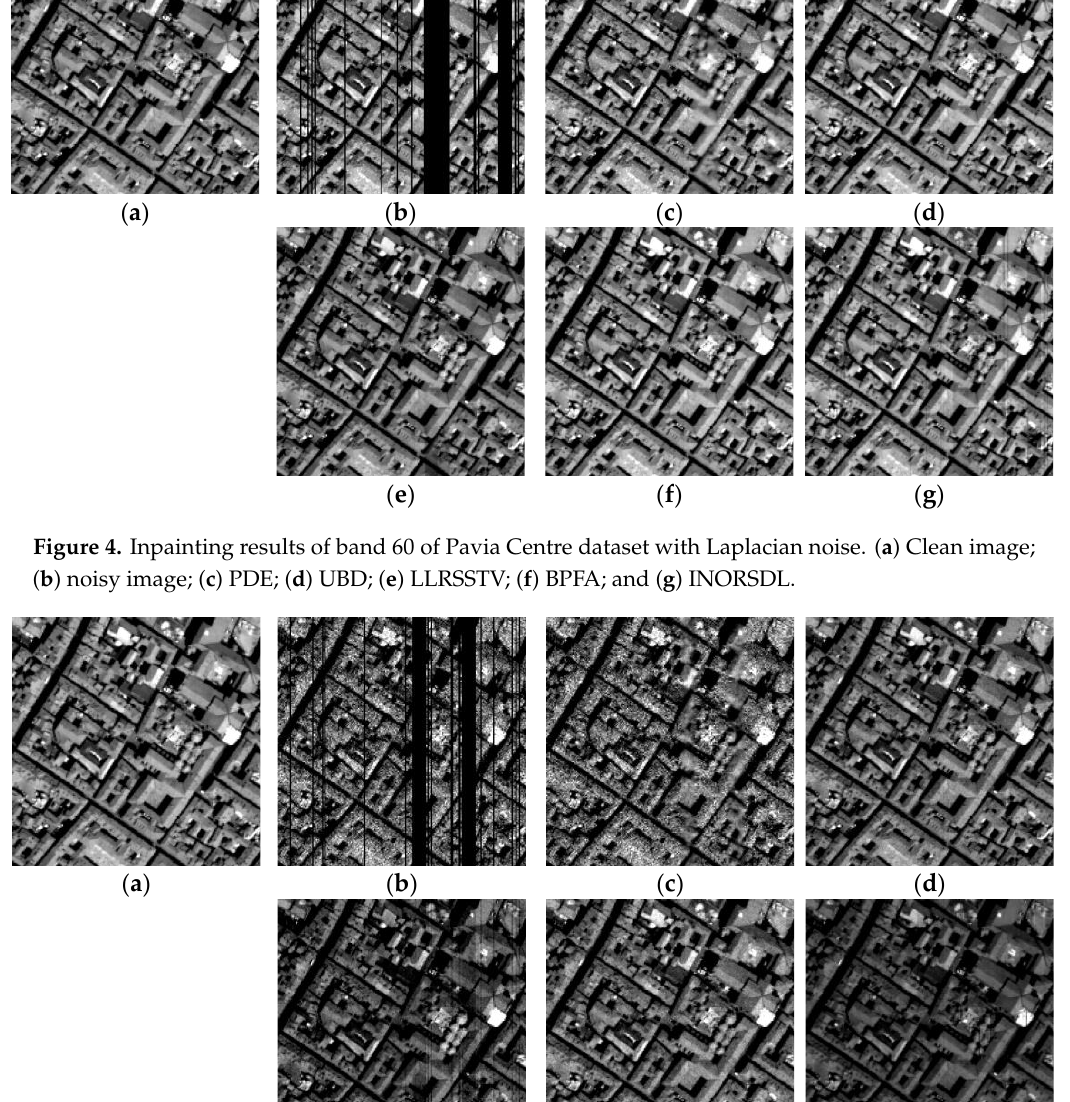
Figure 3. Inpainting results of band 60 of Pavia Centre dataset with Gaussian non-i.i.d. noise. ( a ) Clean